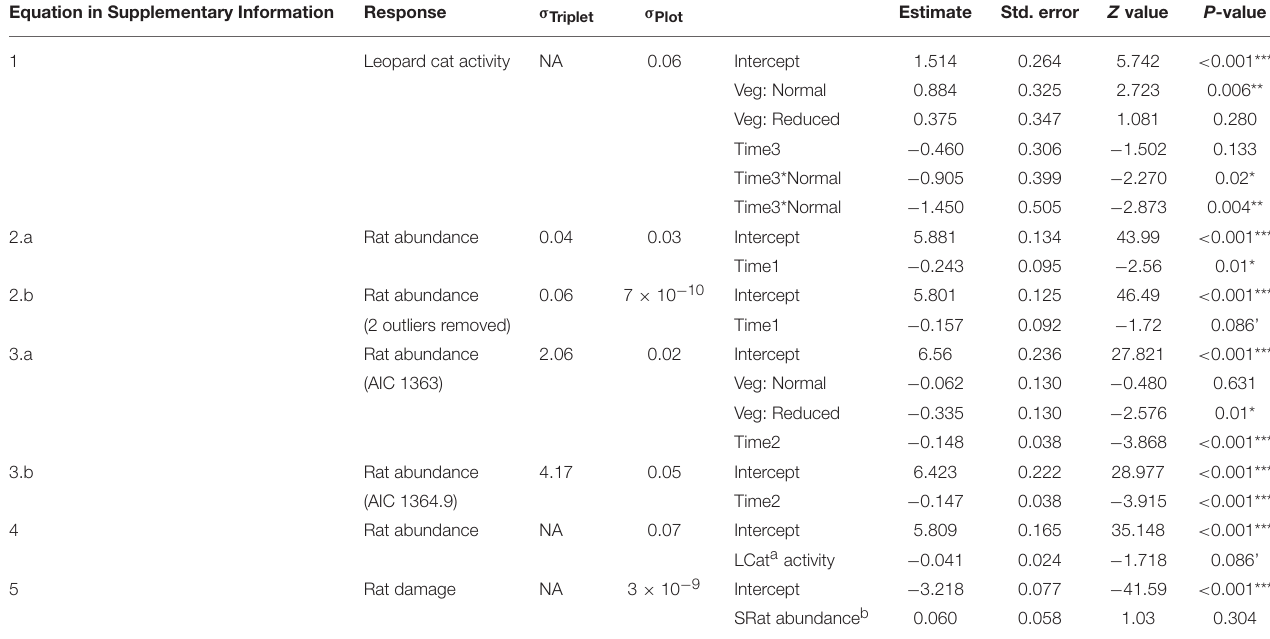
TABLE 2 | Estimated regression parameters (unstandardized), standard errors, z -values and P -values for the GLMMs presented in Supplementary Information . Equation in Supplementary Information